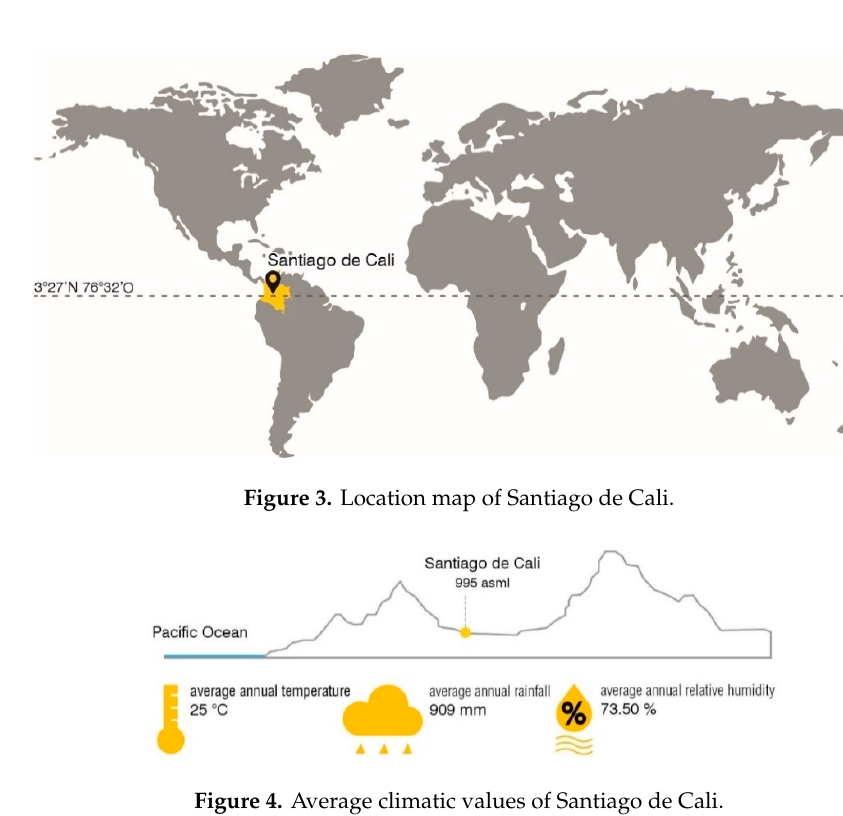
Figure 4. Average climatic values of Santiago de Cali.